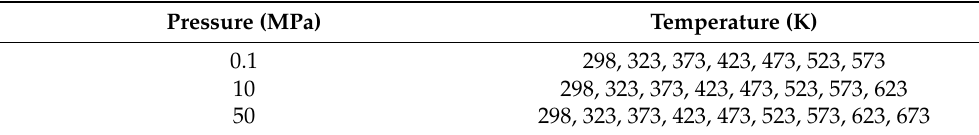
Table 1. Pressure and temperature